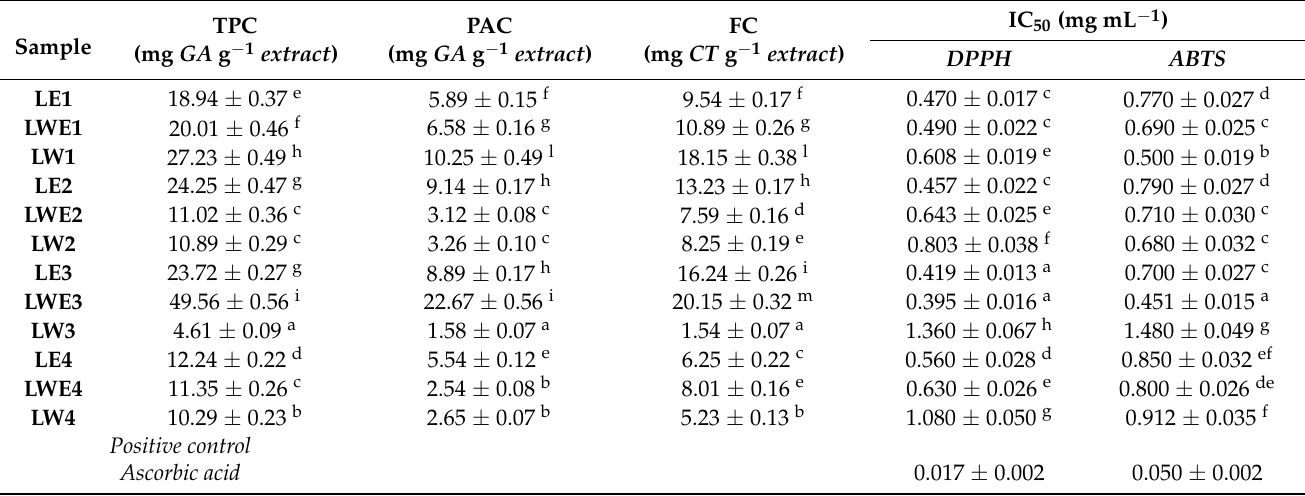
Table 3. Total phenolic content, phenolic acid content, flavonoid content, and antioxidant activity of the extracts from wine